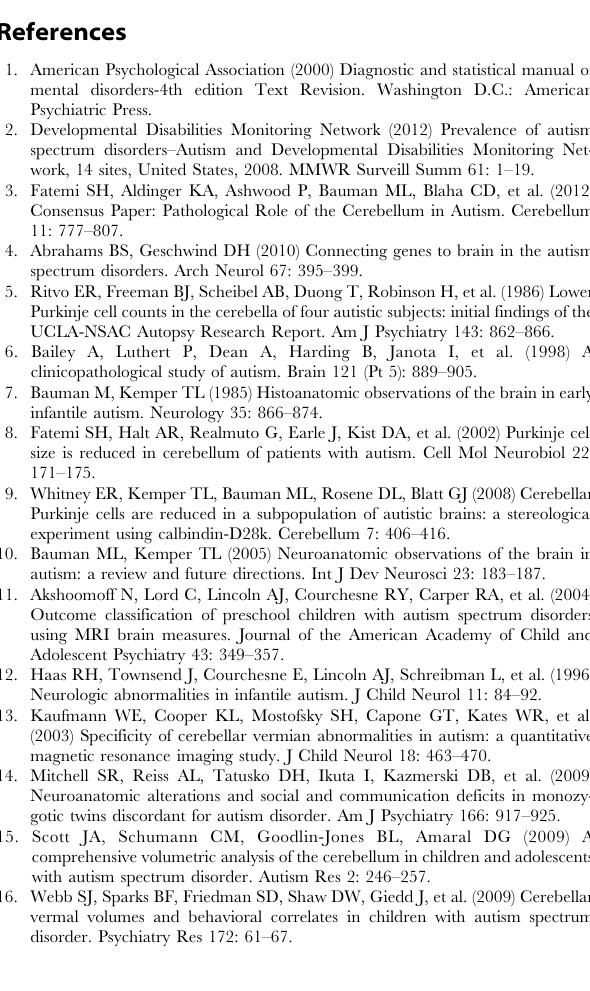
Table S2 Relationships between adaptation perfor- mance and demographic characteristics for healthy control subjects. Table S3 Saccade characteristics of individuals with autism spectrum disorders (ASD) and healthy controls during baseline testing, adaptation and